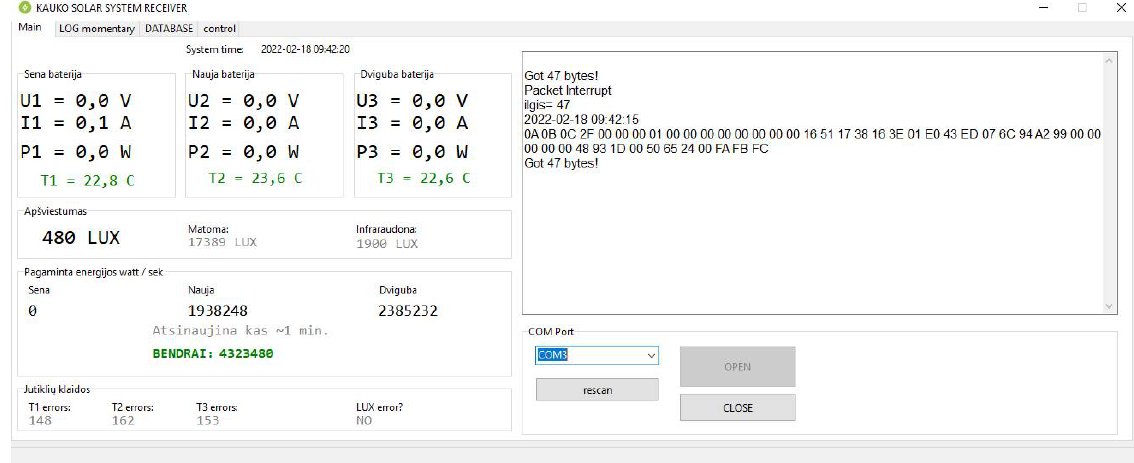
Figure 6. Virtual application designed for displaying and recording data to a MySQL database.